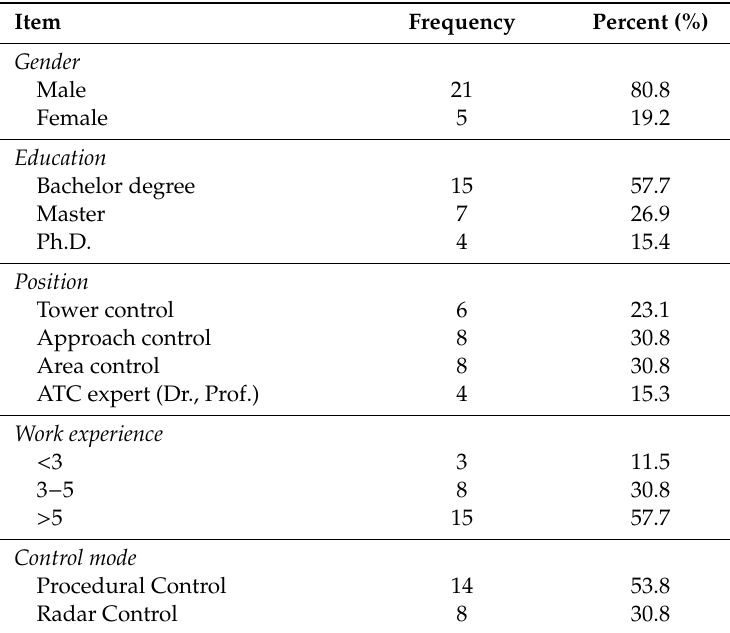
Table 4. Respondents’